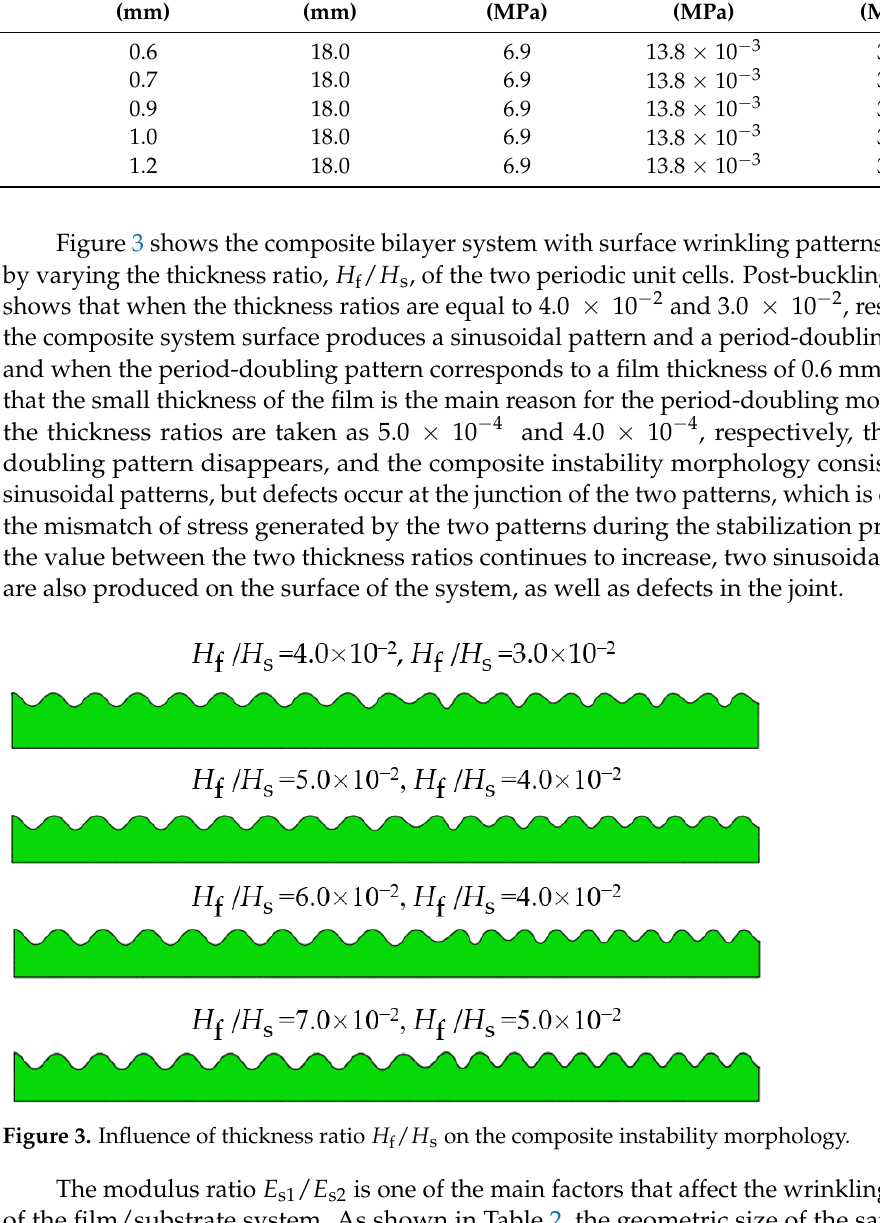
Table 1. Different thickness ratios, H